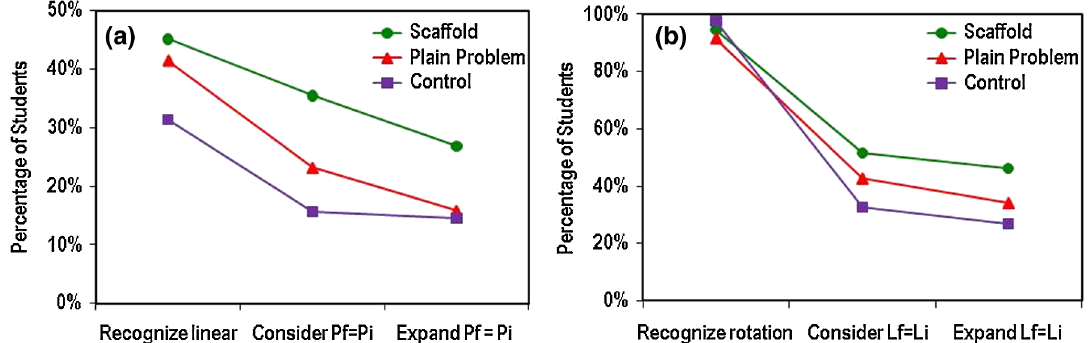
FIG. 7 (color online). Student performance on the final exam synthesis problem. (a) Performance on the linear momentum topic and (b) performance on the angular momentum